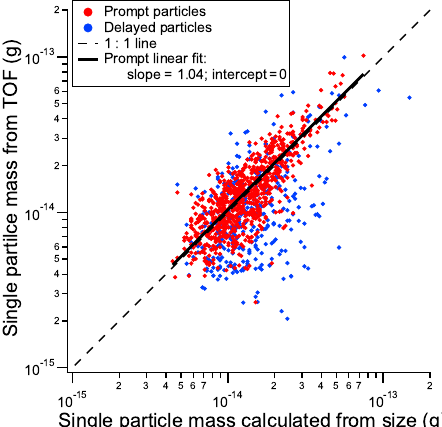
Figure 5. Scatter plot of the single-particle mass from the LSSP mode chemical ion signals vs. that derived from particle size d va-LS by assuming a density of 1.55gcm − 3 for prompt (red) and delayed (blue) particles during the research flight on 6 July 2013. For prompt particles, the slope of the linear correlation is 1.04 with an intercept set to be